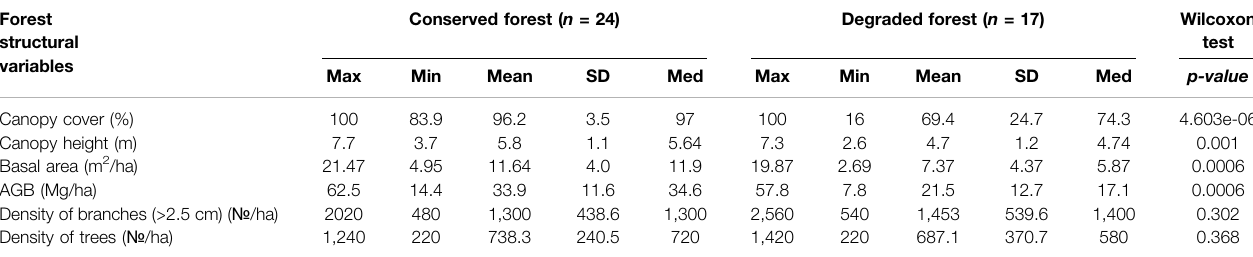
TABLE 1 | Summary of forest structural variables in conserved and degraded forest obtained from fi eld measurements during the dry season. Forest structural